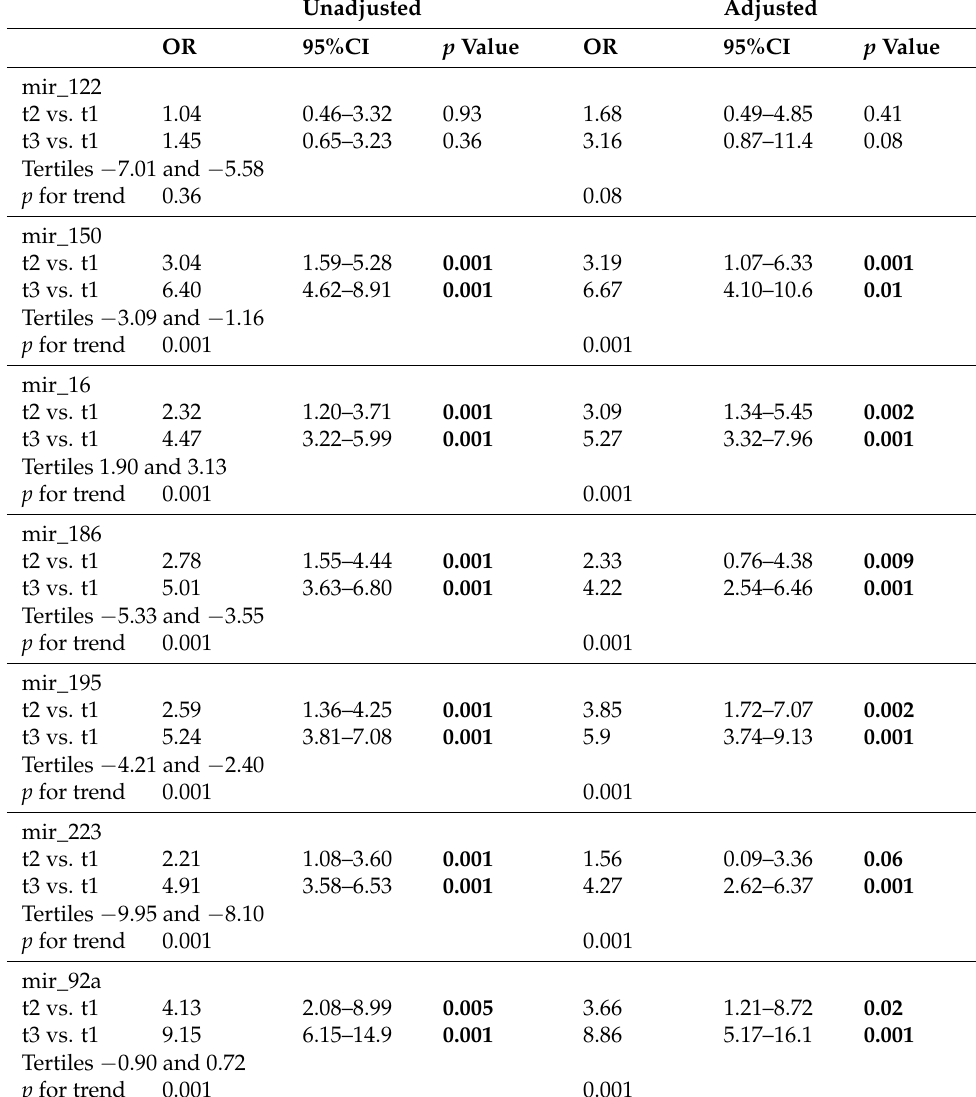
Table 2. Univariate and multivariate logistic regression analyses for the risk of MI (cutoffs = tertiles).